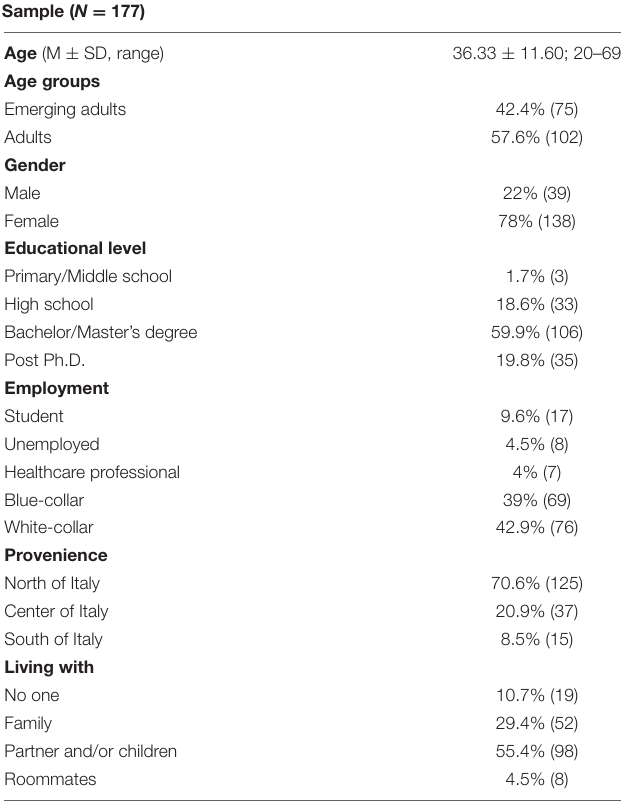
TABLE 1 | Socio-demographic characteristics of the study